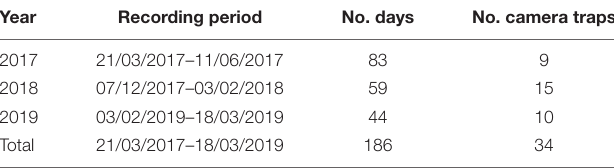
TABLE 2 | Camera trap selection for characterizing the ground-dwelling fauna in the entire studied area including forest patches A, B, C and D along the National Road 2 (NR2) between Régina and Saint-Georges, French